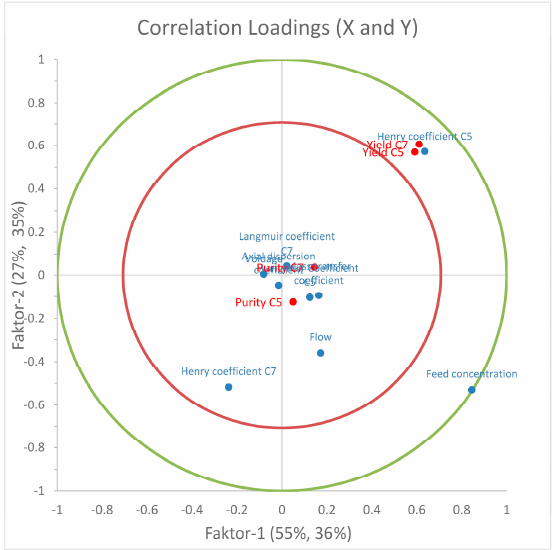
Figure 11. Correlation loadings plot visualizing the dependencies between each variable as found for the Monte Carlo simulations.